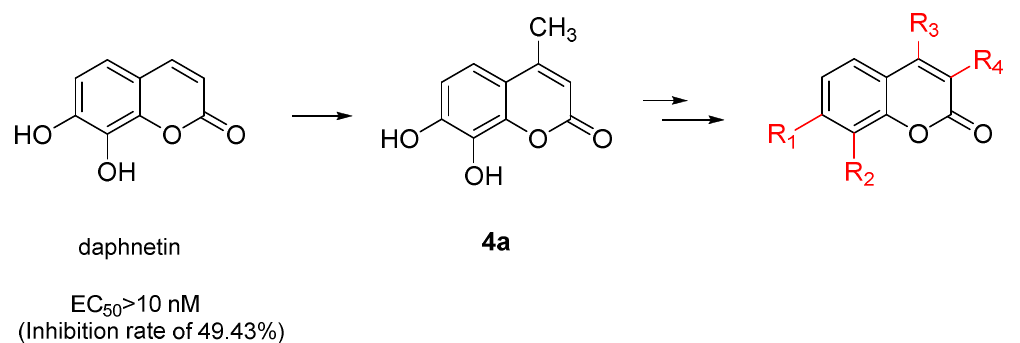
Figure 2. Chemical structures of daphnetin and its derivatives for the development of GPCR inhib- itors/activators.